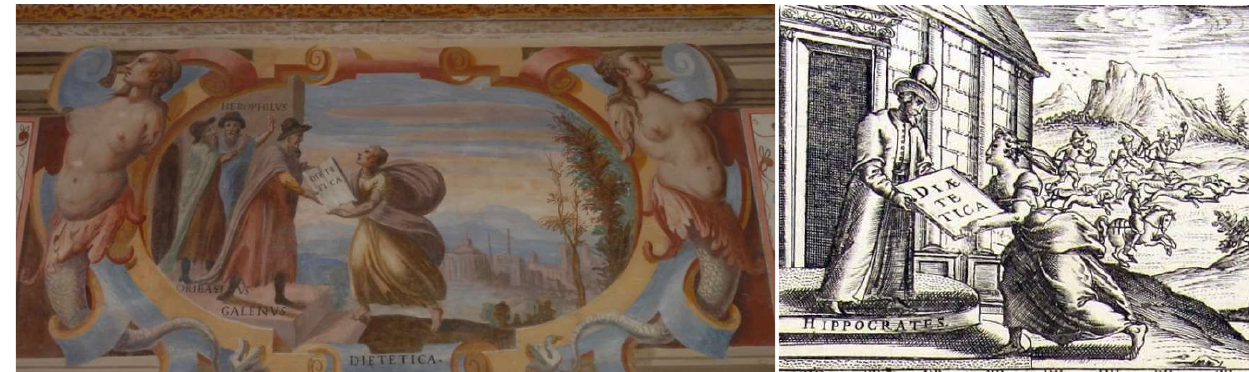
Figure 11. Left : In the oval painting, a messenger receives the book entitled Dietetica from the hands of Galen, while Herophilos and Oribasius are present behind him. Right : Vignette of Giunti’s edition that can be associated with the oval painting, but the messenger receives the book from the hands of Hippocrates.